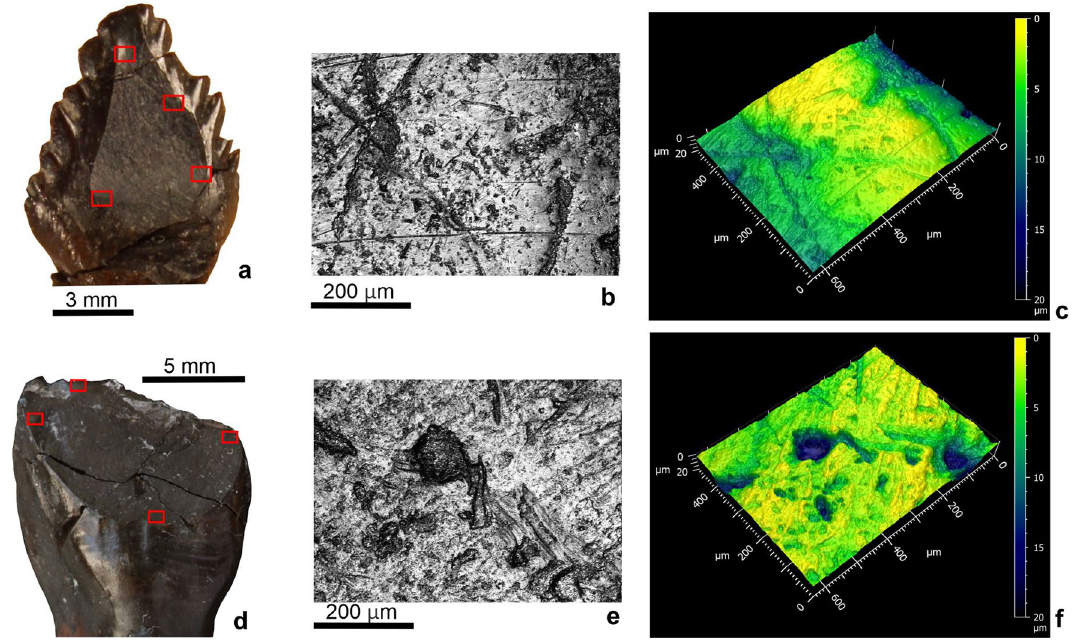
Figure 4. Microwear pattern details. ( a ) Hungarosaurus tormai tooth (MTM 2007.26.13) showing the position of the four areas imaged for traditional (2D) microwear and DMTA. ( b ) an example of one of the micrographs used for the traditional (2D) microwear analysis (PAL 2022.14.1.). ( c ) the same area in 3D for DMTA analysis. ( d – f ), showing the same for a maxillary tooth of Mochlodon vorosi (MTM